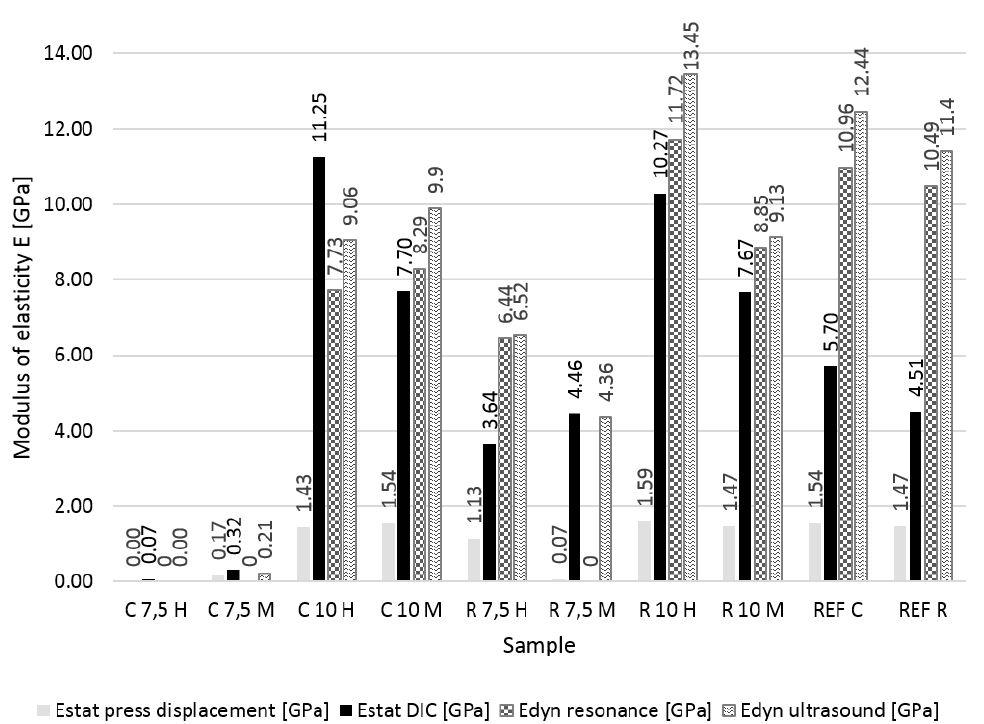
Figure 3. Results of static and dynamic moduli of